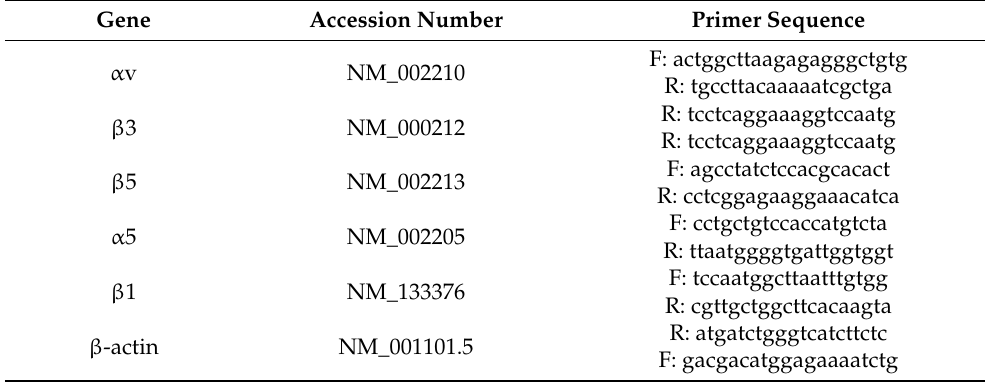
Table 1. Primers used to amplify RGD-binding integrin mRNA in real-time qRT-PCR